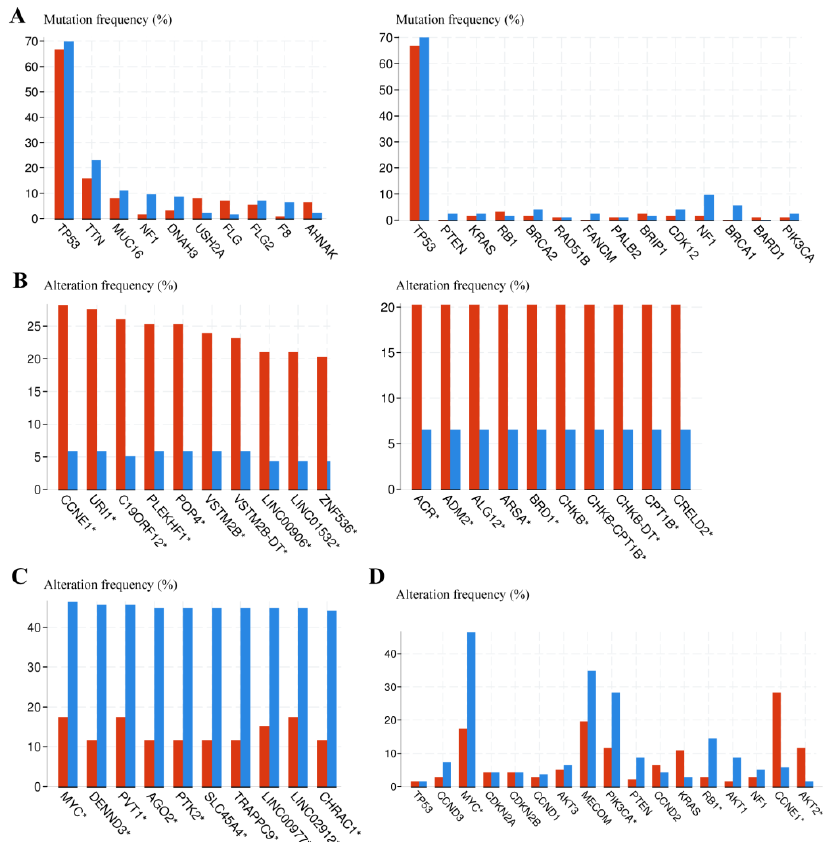
Figure 6. Comparison of genetic alterations between near-euploid and highly-aneuploid ovarian cancer patients. ( A ) Mutation frequency in highly-aneuploid (high-aneuploid score) group and near-euploid (low-aneuploid score) group. Left panel: Gene mutations with the highest frequency in any group; Right panel: Common mutations in serous ovarian cancer. (Blue: euploid group; red: aneuploid group). ( B ) Copy number alterations enriched in the highly-aneuploid group. Left: amplification; right: deletion. ( C ) Copy number alterations enriched in the near-euploid group. ( D ) Copy number alterations of genes frequently altered in serous ovarian